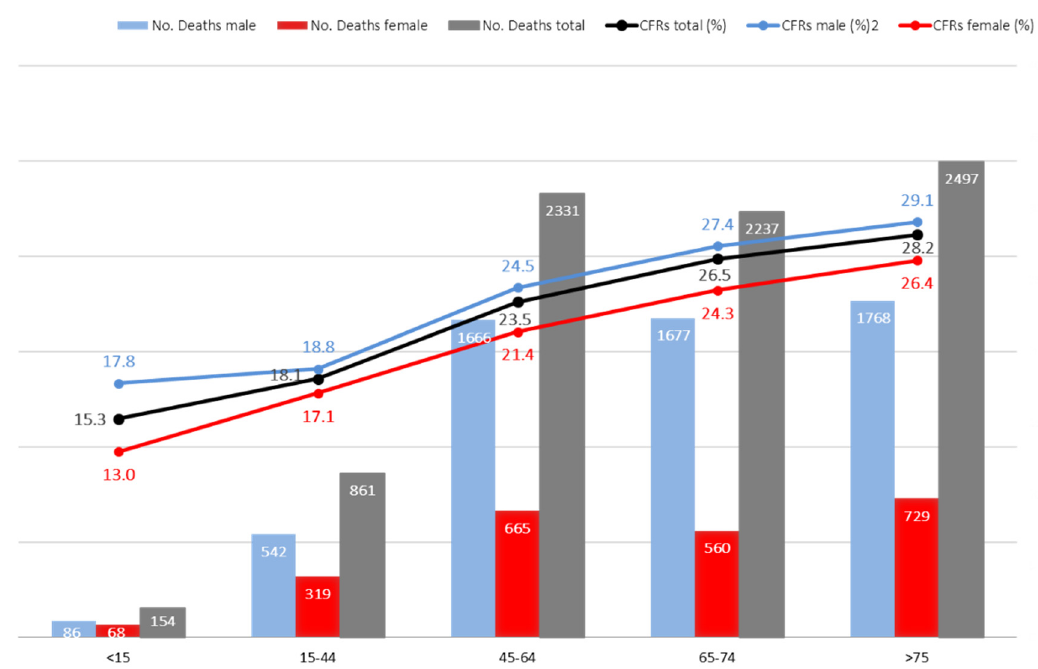
Figure 2. CFRs by age and gender distribution.